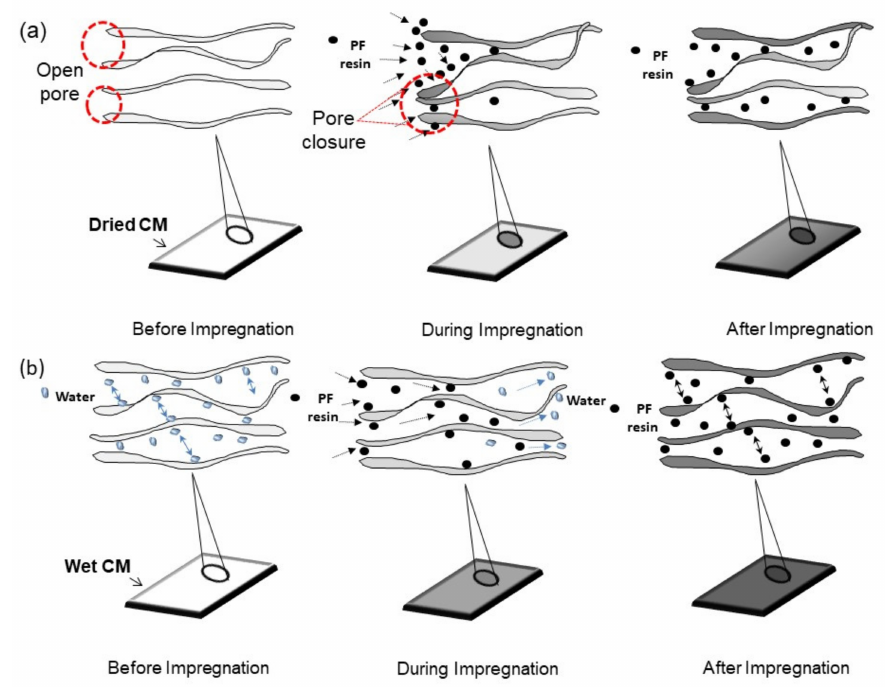
Figure 3. Schematic diagrams for PF uptake in ( a ) dried and ( b ) wet